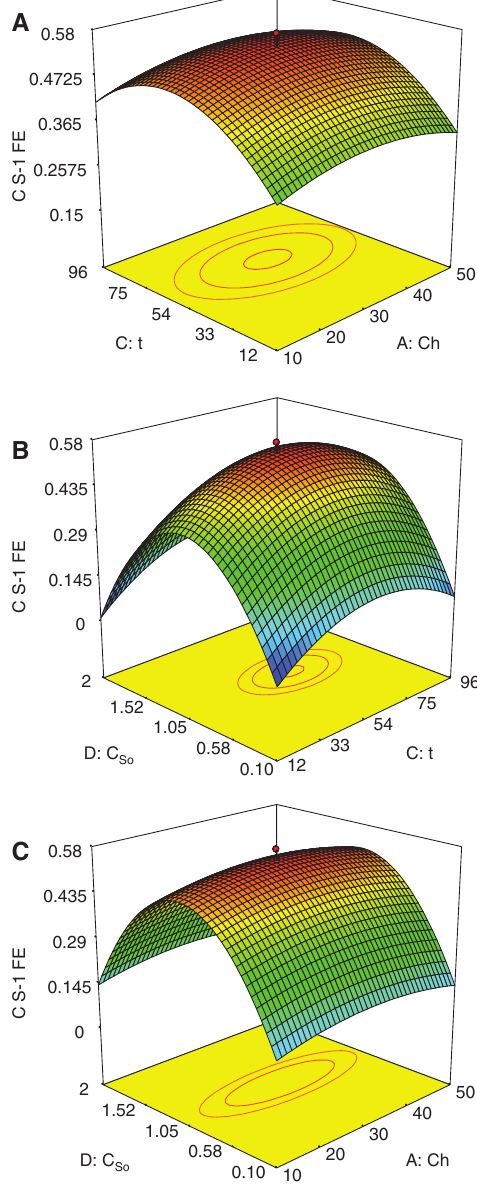
Figure 2: (A) 3D-plot between any two parameters for the concentra- tion of product. Effect of time and concentration of the cell; (B) effect of time and concentration of the substrate; (C) effect of concentra- tion of the cell and concentration of the